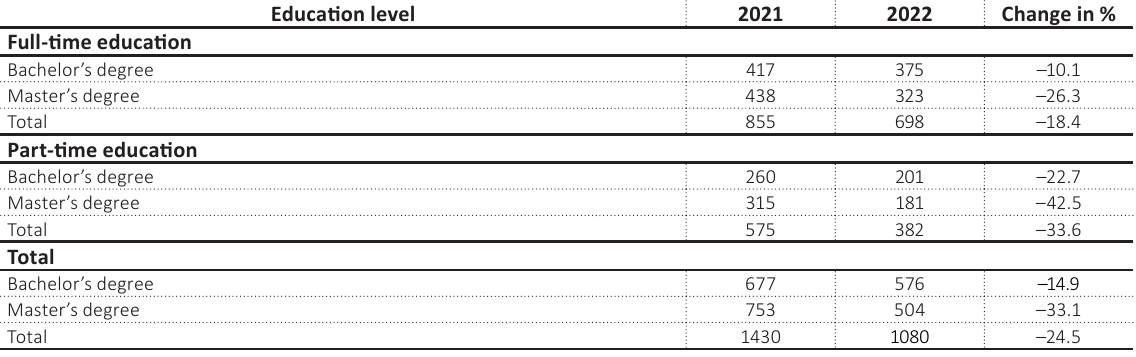
Table A1. Number of higher education students who graduated from university in the year